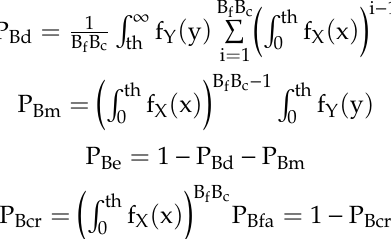
Figure 12. P (cid:2886)(cid:2914) and P (cid:2886)(cid:2923) versus multiple parameter T . Figure 12. P Bd and P Bm versus multiple parameter